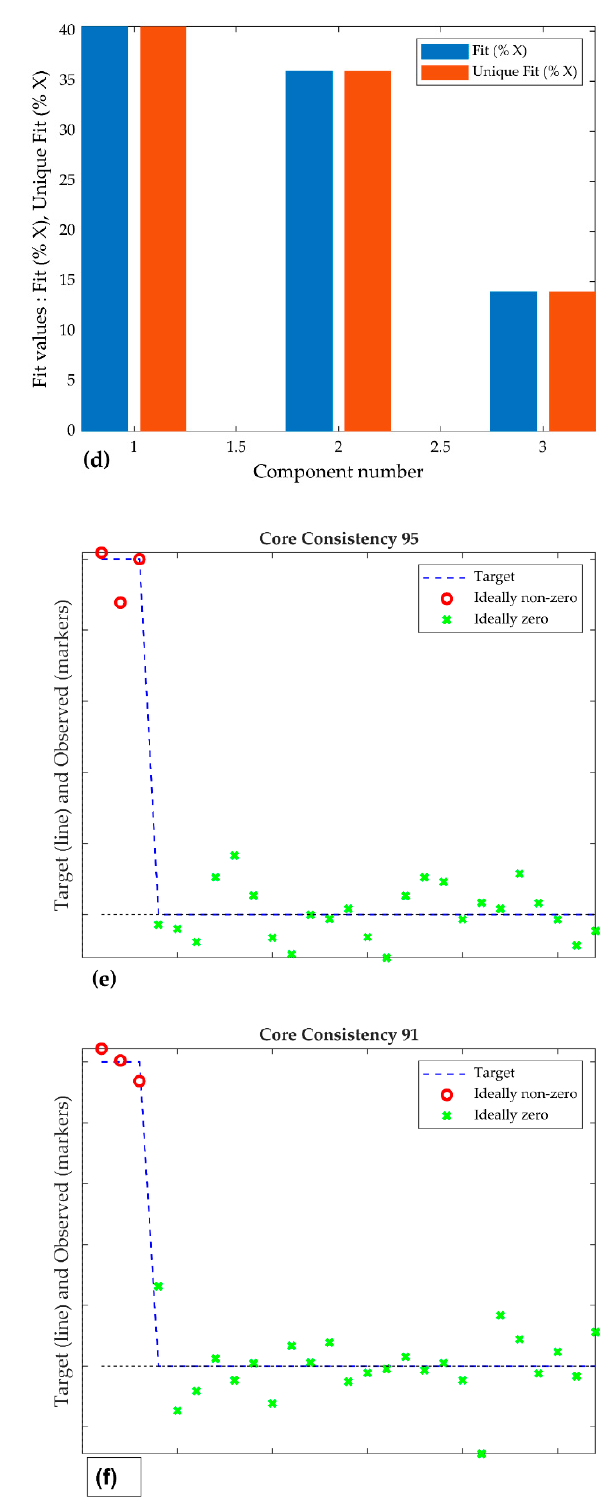
Figure 4. Diagnostic of the Parallel Factor Analysis (PARAFAC) models. ( a ) Residuals sum of squares of TGIS, ( b ) residuals sum of squares of TGO, ( c ) model fit and unique fit of component in TGIS, ( d ) model fit and unique fit of components in TGO, ( e ) core consistency of TGIS, and ( f ) core consistency of TGO.